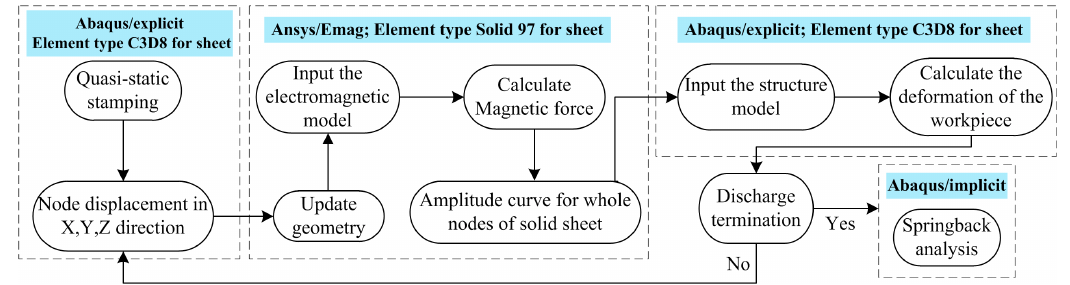
Figure 1. Simulation strategy for springback control by EMF.